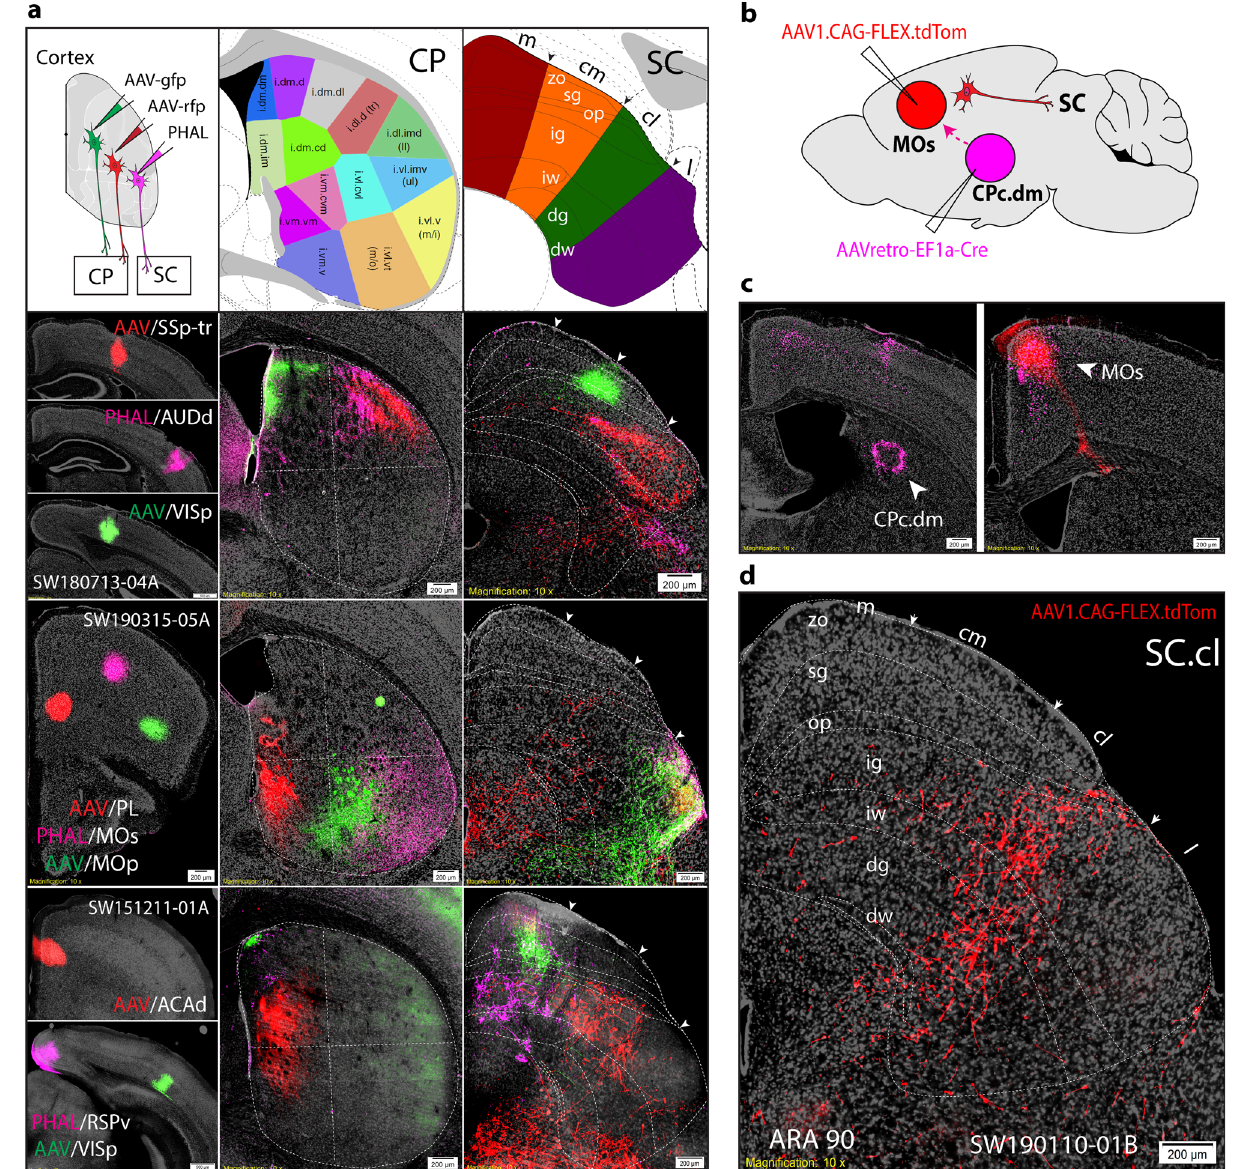
Fig. 6 Cortico-striatal and cortico-tectal have conserved topography. Within the cortex, somatic sensorimotor areas are each organized into distinct highly interconnected subnetworks that integrate the visual fi eld, somatotopic body map and higher-order areas which then project subcortically to the caudoputamen (CP) into distinct domains 19,20 . Each cortical area sends parallel descending projections to SC zones and CP domains. a Three separate triple anterograde cases into different cortical areas send topographic projections to corresponding caudate putamen (CP) domains and SC zones. b Injection site schematic of combinatorial tract-tracing method using AAVretro-Cre injection (in CPc.d at ARA 57) and Cre-dependent AAV-mCherry (in MOs at ARA 47). c Injection sites in CPc.dm and MOs within the same mouse brain (SW190110-01B). d Red anterograde labeling demonstrates a subset of MOs cortical projecting neurons (presumably pyramidal tract projection neurons or PT neurons) generate collateral projections speci fi cally to the SC.cl zone and CPc.dm. Scale bars are 200 µ m. Color-code associations: red (SC.m), orange (SC.cm), green (SC.cl), purple (SC.l). SC superior colliculus, SC layers: zo zonal, sg super fi cial gray; op optic, ig intermediate gray, iw intermediate white, dg deep gray, dw deep SC.m, SC.cm, as well as SC.cl (Fig. 5c) that align with patterns In parallel, we demonstrate a re fi ned network of organization from cortico-tectal projections from these high order association of parallel channels relayed through the cortico-tecto-thalamic areas (see Fig. 3a). In contrast, the centrolateral domain of the circuit. This is most evident in somatotopic maps from SSp and SNr (SNr.cl), which receives the densest inputs from the MOp to SC.cl and SC.l zones. The four SC zones project to at dorsolateral striatal domains that are innervated by the MOp least four domains within the PF, where SC.cl/SC.l → PF.m/ul, and SSp trunk and lower limb domains, project speci fi cally to the SC.cm/cl → PF.tr/ll, and SC.m → PF.as (Fig. 5e). Output projec- SC.cl. Finally, the SC.l receives dense inputs from the SNr domain tions from SNr domains also target the same somatotopic zone (Fig. 5c) that is speci fi cally innervated by the ventrolateral CP in SC as well as the corresponding domain in PF. To show the domains, which receive convergent somatic sensorimotor cortical subnetwork interactions of this cortico-tecto-thalamic pathway inputs associated with orofacial and upper limb (Fig. 6a). and reveal mono-synaptic inputs to the PF-projecting neurons